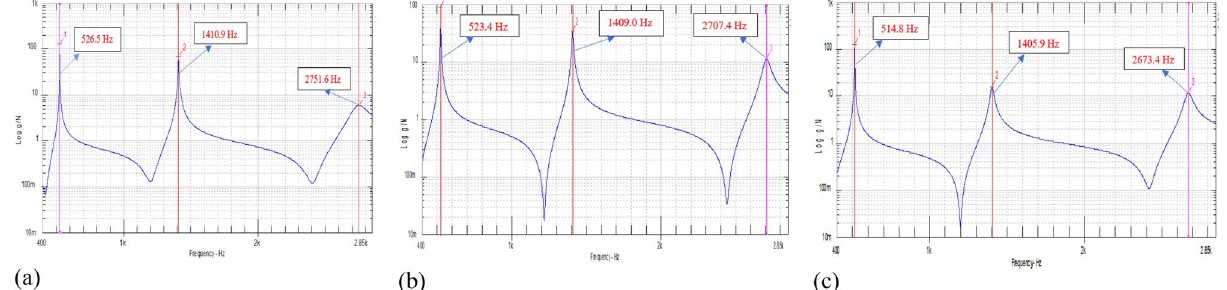
Figure 6. Damaged cases: ( a ) intact case; ( b ) depth of cut—3 mm; ( c ) depth of cuts—6 mm.